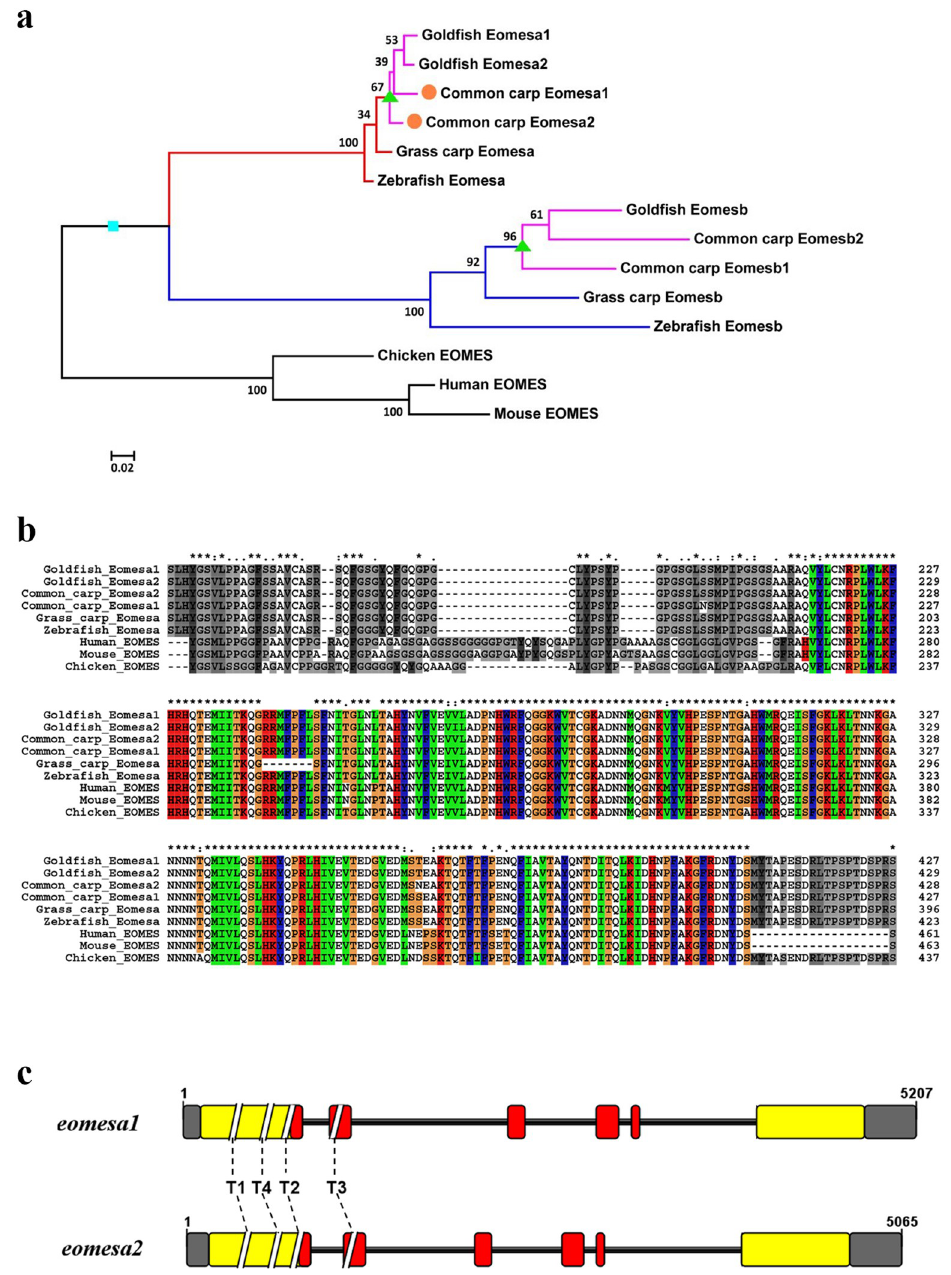
Fig 1. The phylogenetic tree, amino acid alignment of Eomes in vertebrates, and the schematic diagrams of the eomesa gene structure. (a) The phylogenetic tree was constructed using the ML method with 1,000 bootstraps. The cyan square represents teleost-specific whole genome duplication (TS-WGD, or 3R-WGD) and green triangles represent the fourth-round whole genome duplication (4R-WGD) occurred before the speciation of the common ancestor of common carp and goldfish. (b) Dashes are introduced to improve the alignment. The T-box domain is marked by colored boxes. (c) The gray boxes indicate untranslated regions. Yellow boxes indicate exons, and red boxes indicate exons encoding the T-box domain. The dash lines indicate the target sites.